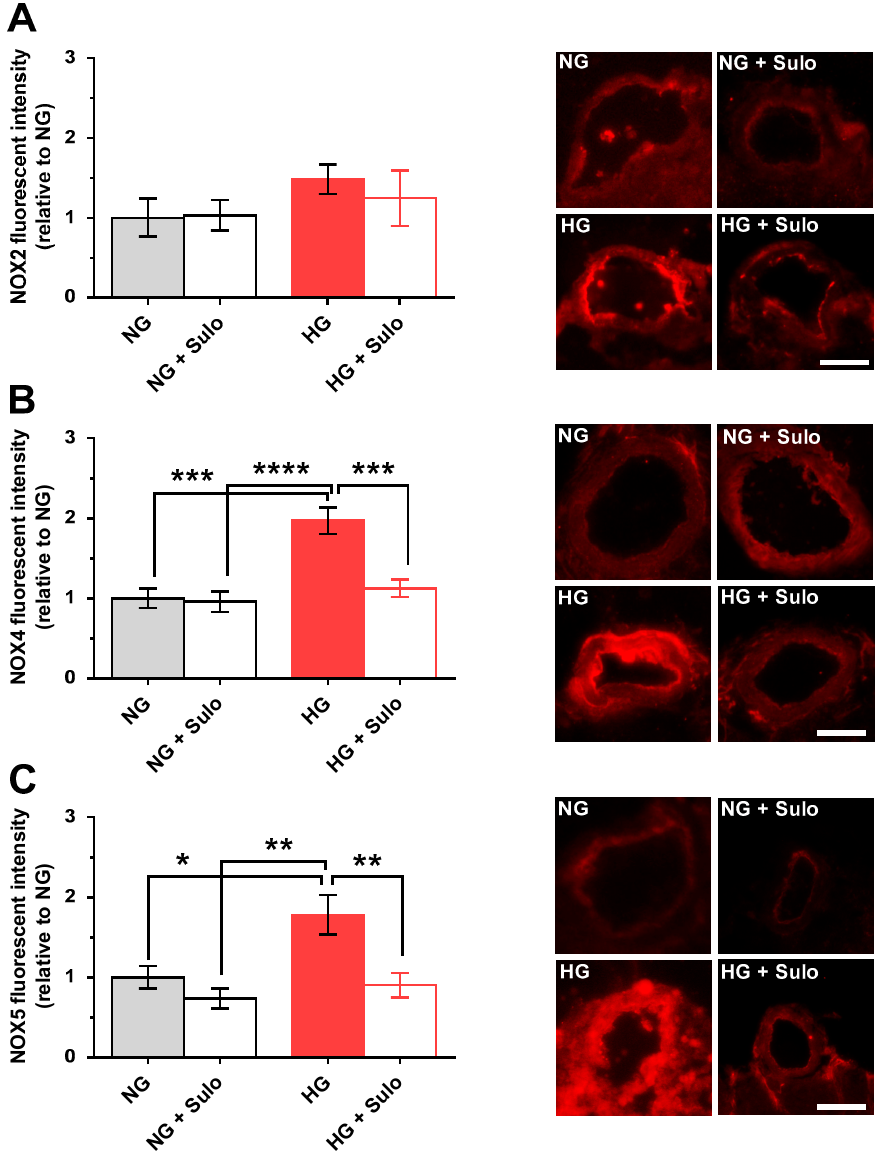
Figure 6. Immunofluorescence micrographs of retinal arteriole cross-sections (cryosections) stained with a primary antibody (Abcam, Waltham, MA, USA, dilution 1:200, incubation time: 2 h at RT) targeted against NOX2 (ab80508), NOX4 (ab154244), and NOX5 (ab191010) and a rhodamine Red- X-coupled secondary antibody (Dianova GmbH, Hamburg, Germany, 111-295-003, dilution 1:200, incubation time: 2 h at RT) (red color). Quantification of fluorescent intensities in the vascular wall of retinal arterioles normalized to NG. ( A ) Immunoreactivity to NOX2 was similar in all groups. ( B ) In contrast, immunoreactivity to NOX4 was elevated in the HG group. ( C ) Likewise, immunoreactivity to NOX5 was increased in the HG group. Data are expressed as mean ± SE ( n = 8 per group; * p < 0.05, ** p < 0.01, *** p < 0.001, **** p < 0.0001). Scale bar = 50 µ